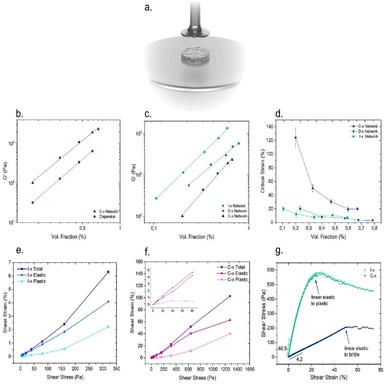
(a.) Artistic schematic of a pre-formed hydrogel prior to testing (b.) Comparison of G' as a function of cellulose vol. fraction before and after polymerization (c.) Comparison of G' and (d.) critical strain of the crosslinking methods studied as a function of vol. fraction. Total, plastic and elastic deformation from creep and recovery measurements for (e.) I-x and (f.) C-x at 0.9 wt% CNF with a zoom-in at lower shear strains (g.) Deformation transitions of I-x and C-x to either plastic or brittle during s